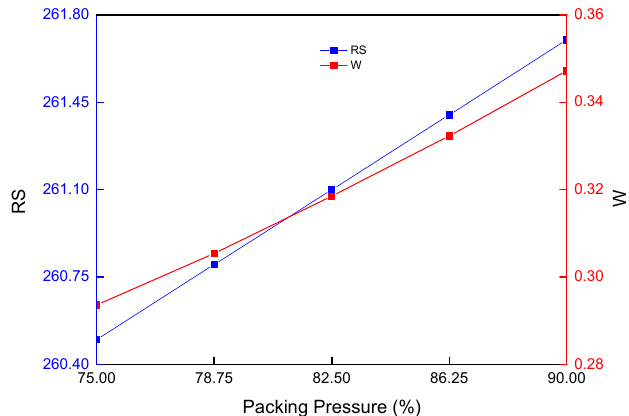
Figure 13. The effect of packing pressure on the residual stress and warpage.